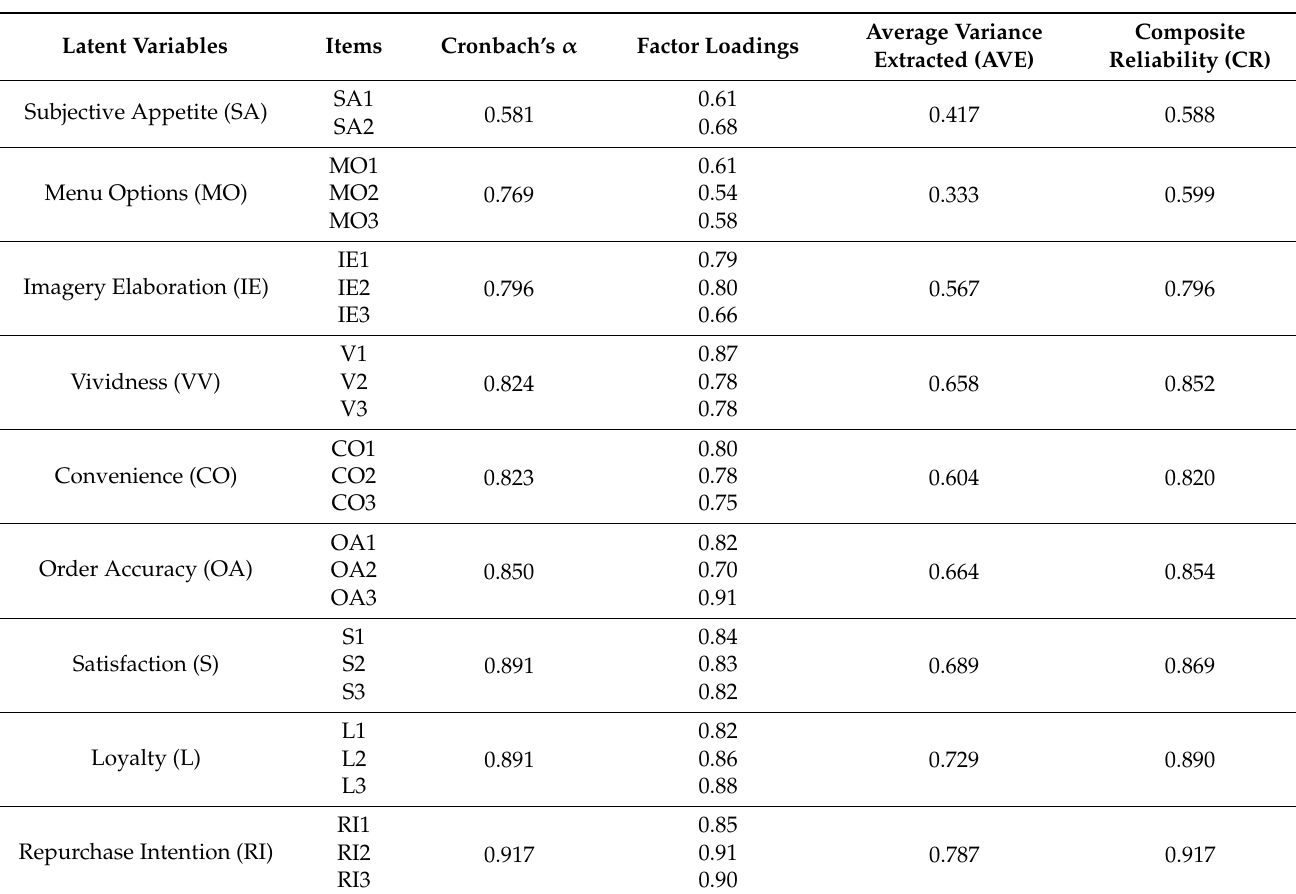
Table 4. The construct’s validity and reliability.